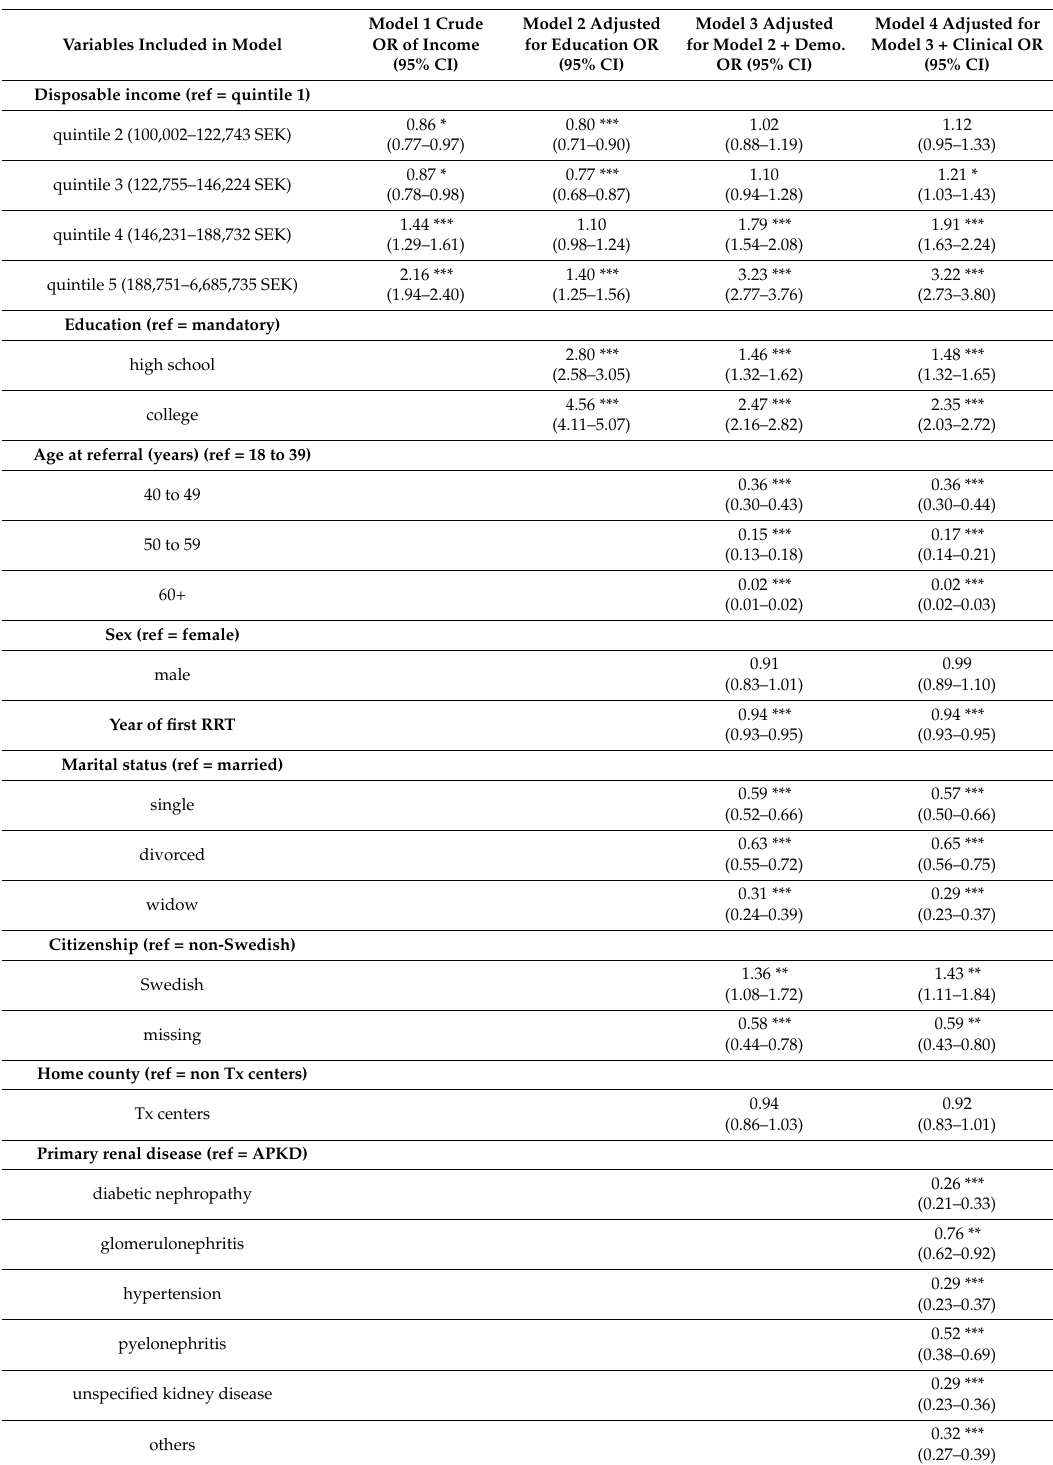
Table 2. The association between income and access to kidney transplantation by the multivariate logistic